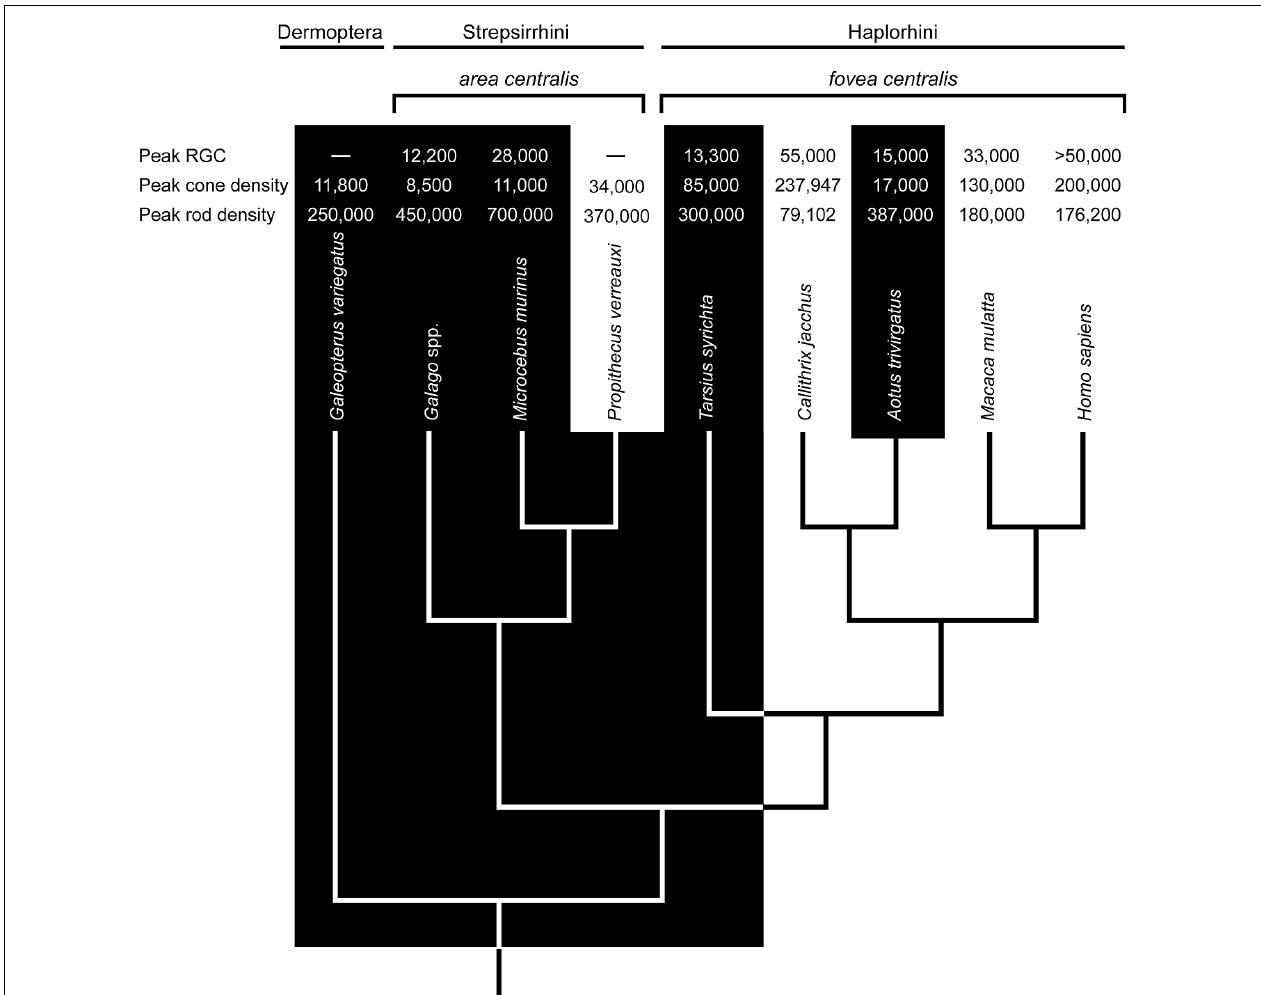
FIGURE 1 |The phyletic relationships of select primates and the sister taxon Dermoptera (the Sunda colugo, Galeopterus variegatus ). The distinction between nocturnal (black zone) and diurnal (white zone) activity patterns is strongly associated with variation in retinal ganglion cell (RGC) counts (mm − 2 ), cone densities (mm − 2 ), and rod densities (mm − 2 ) in the area centralis or fovea centralis (data sources: Webb and Kaas, 1976; Perry and Cowey, 1985; Curcio etal., 1990; Wikler and Rakic, 1990; Silveira etal., 1993; Ogden, 1994; Wilder etal., 1996; Hendrickson etal., 2000; Dkhissi-Benyahya etal., 2001; Peichl etal.,